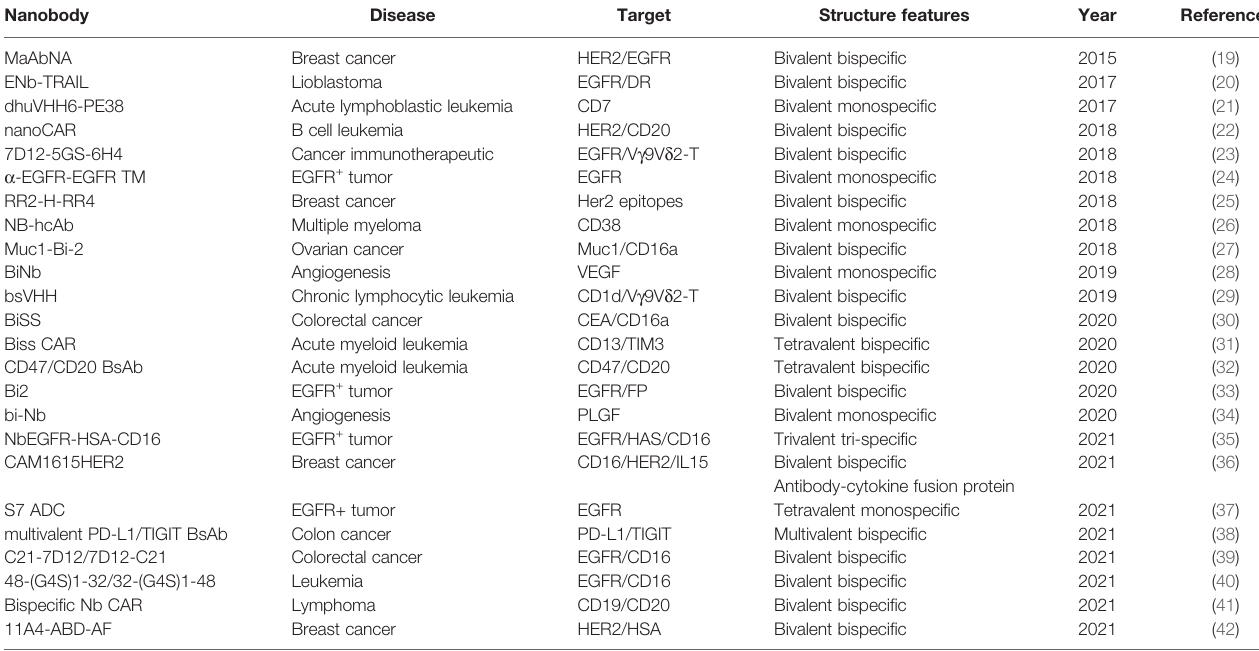
TABLE 2 | Multivalent/bispeci fi c nanobodies proposed for cancer therapy.